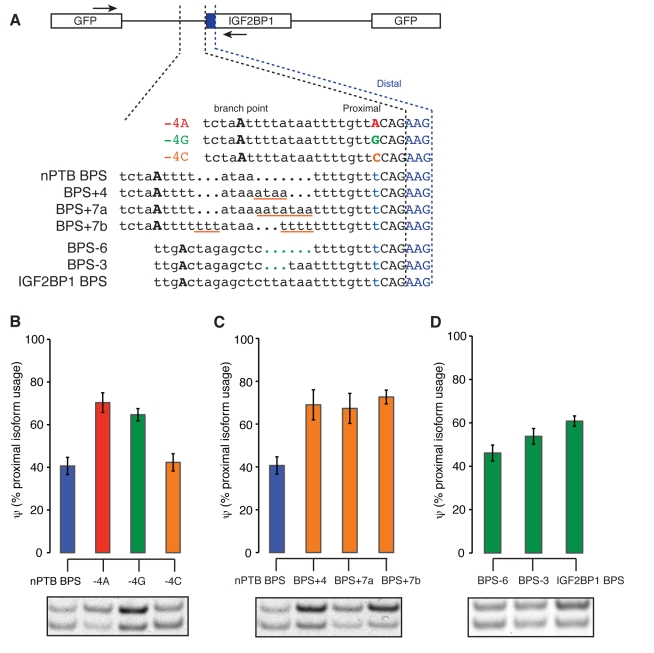
Specific intronic sequence features regulate NAGNAG splicing.(A) Illustration of NAGNAG minigene constructs, designed to test the roles of the branch point to 3′ splice site distance and of the −4 base in NAGNAG splicing. A short segment of intronic sequence spanning the branch point to the 3′ splice site of the PTBP2 NAGNAG was cloned upstream of the IGF2BP1 exon. To confirm the importance of a pyrimidine at the −4 position for distal NAG use, the effects of all four nucleotides at the −4 position were tested. The branch point to 3′ splice site distance was varied by introducing nucleotides (underlined in orange) in constructs containing the PTBP2 branch point sequence, or by removing nucleotides (indicated by green dots) in constructs containing the IGF2BP1 branch point sequence. Locations of RT-PCR primers are indicated by arrows. (B) Proximal isoform expression increased dramatically after the introduction of a purine at the −4 position. Splicing was monitored after minigene transfection into HEK293T cells by RT-PCR. Mean and standard deviation of at least three independent transfections are shown. A representative gel is shown below (top and bottom bands represent proximal and distal isoforms, respectively). (C) As in (B), but varying the branch point to 3′ splice site distance in the context of the native nPTB branch point sequence. The distance was increased by insertion of four or seven nucleotides of sequence of varying purine/pyrimidine composition as shown in (A). (D) As in (C), but decreasing the branch point to 3′ splice site distance in the context of the exogenous IGF2BP1 BPS by deletion of three or six bases as shown in (A).